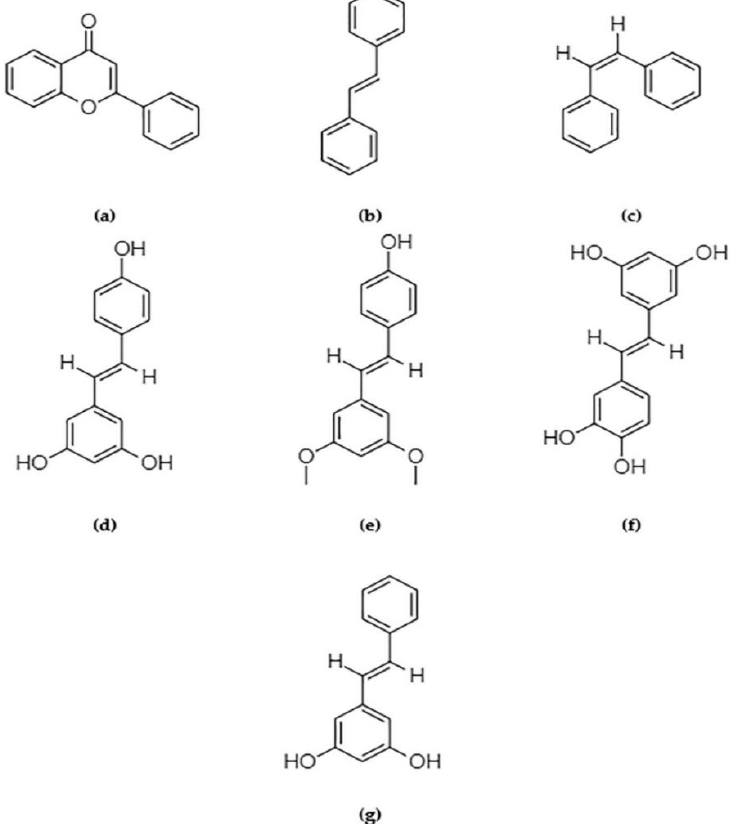
Figure 1. Structural difference between the molecular skeleton of flavones and stilbenes ( a – c ): ( a ) 15 carbon skeleton of flavonoids featuring a benzo- γ -pyrone structure; ( b ) trans-stilbene; ( c ) cis-stilbene; ( d ) resveratrol; ( e ) pterostilbene; ( f ) piceatannol; ( g ) pinosylvin. All of the chemical formulas are obtained from the PubChem database and are drawn with the help of ChemDraw.